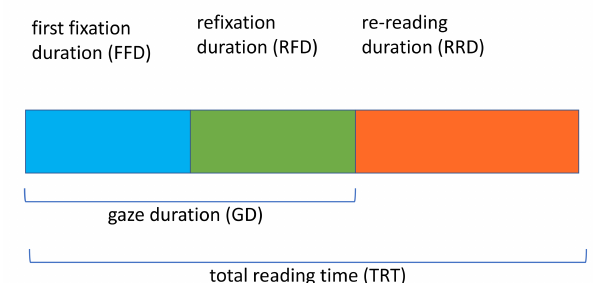
Figure 1. The word-viewing time decomposition used in this paper allows the separate components of first-fixation duration (FFD), refixation duration (RFD), and re-rereading duration (RFD) to be combined additively to give the total reading time on the word. The commonly used gaze duration (GD) measure is the sum of FFD and